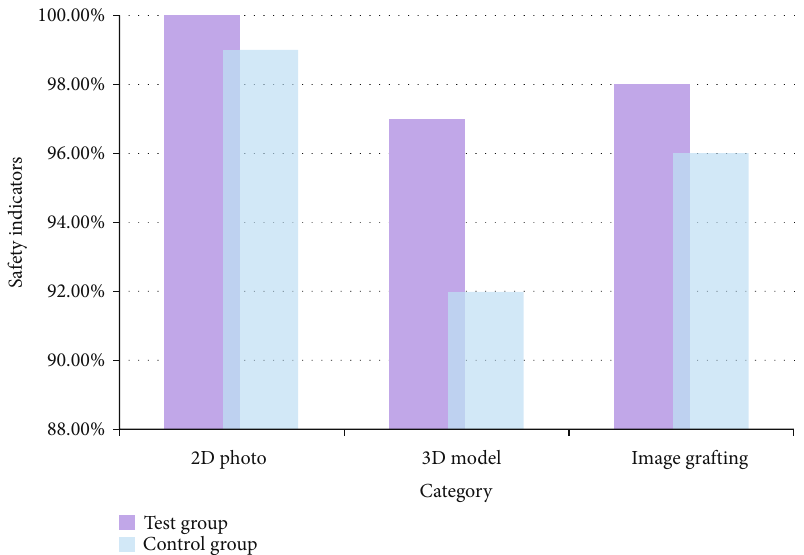
Figure 10: Facial recognition